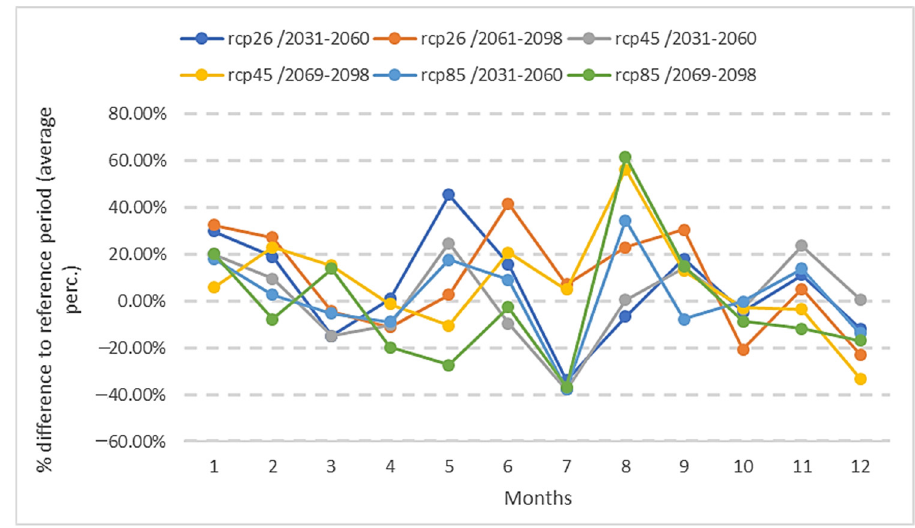
Figure 7. Percentage differences in average monthly rainfall for all climate scenarios relative to the average monthly rainfall in the reference period.